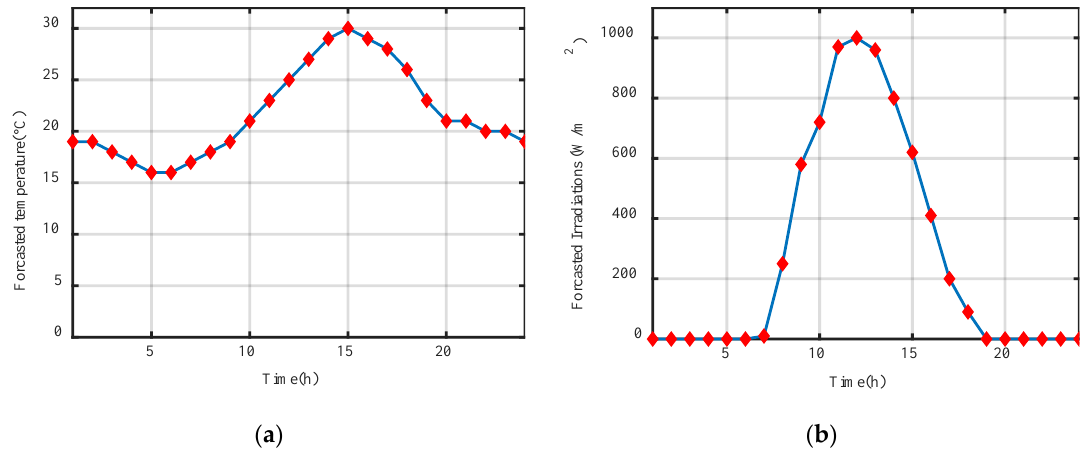
Figure 7. Forecasted temperature ( a ) and radiation intensity ( b ).